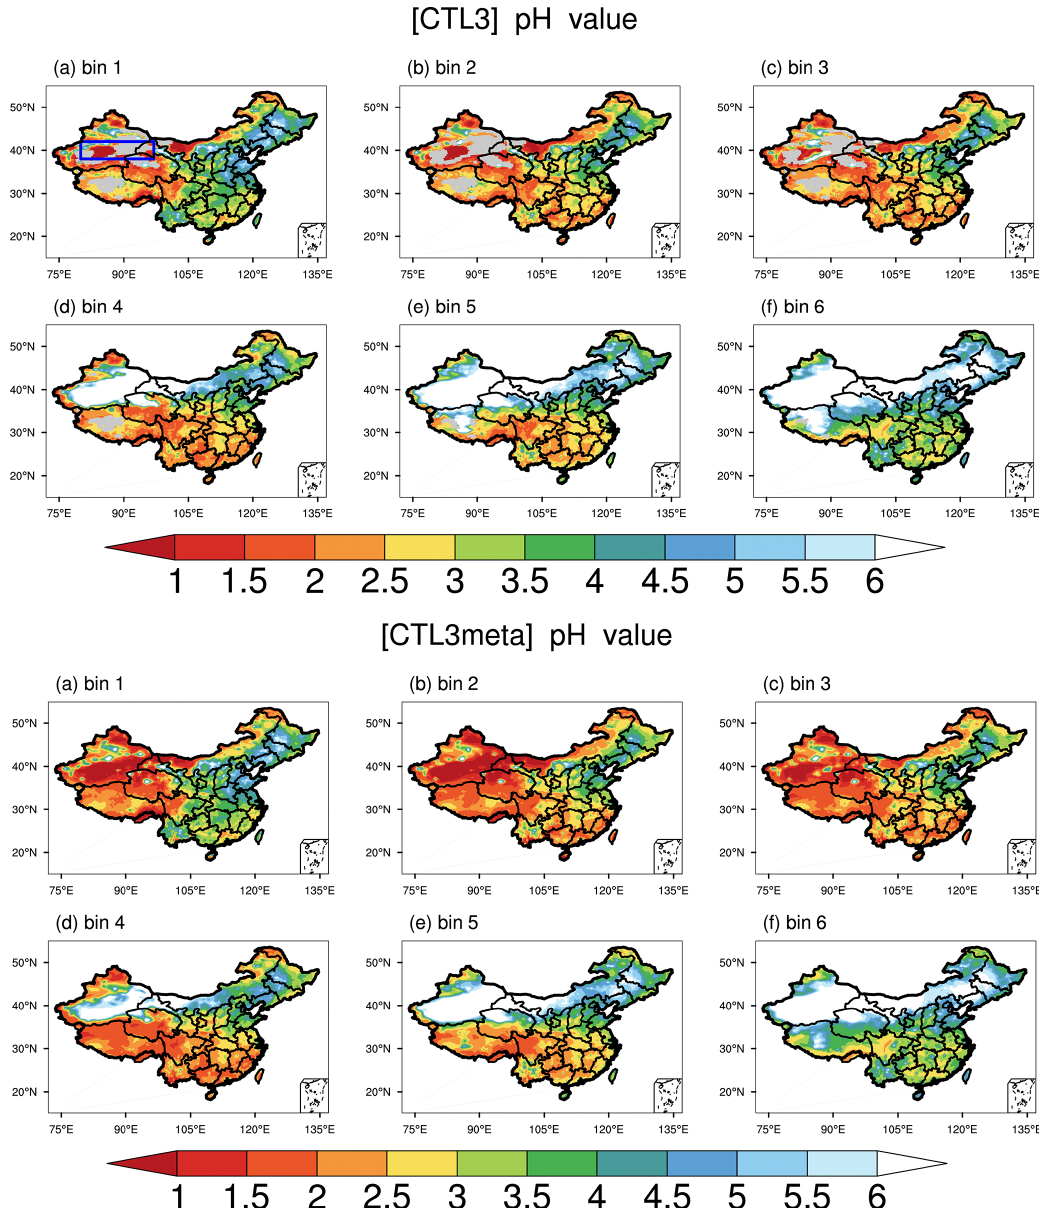
Figure 7. Spatial distributions of mean surface aerosol pH during the study period of 15 October–2 November 2014 predicted by the CTL3 scenario (top panel) and CTL3meta scenario (bottom panel) for six size bins: (a) bin 1 for 0.039–0.078µm diameter, (b) bin 2 for 0.078– 0.156µm diameter, (c) bin 3 for 0.156–0.312µm diameter, (d) bin 4 for 0.312–0.625µm diameter, (e) bin 5 for 0.625–1.25µm diameter, (f) bin 6 for 1.25–2.5µm diameter. The blue box in the top panel (a) represents the focus area of analysis to